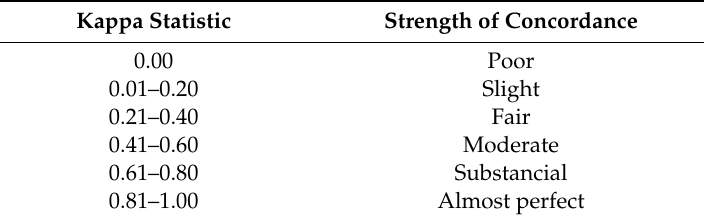
Table 8. Strenght of concordance for kappa statistic.